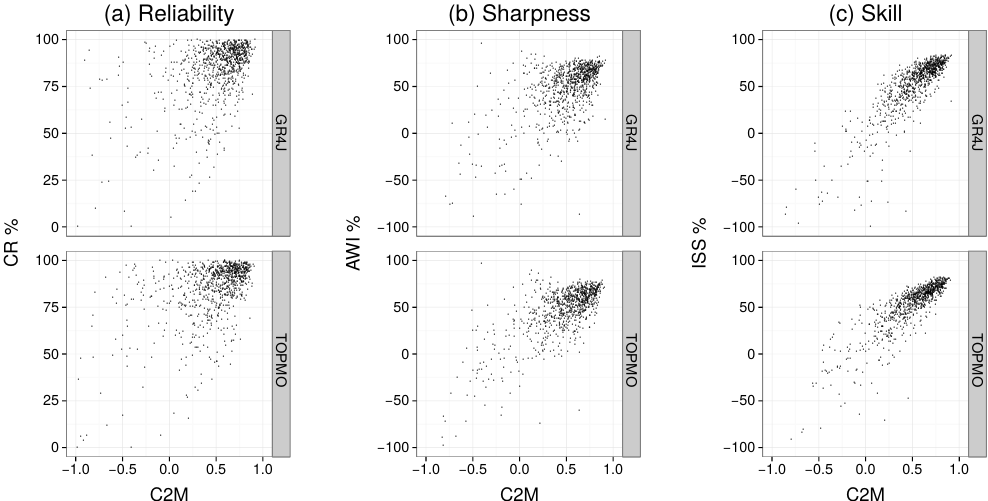
Figure 7. Impact of deterministic performance, as quantified by the bounded C2M quadratic criterion, on the three performance criteria for the 907 catchments. Note that for easier visualisation, the lower limits of the AWI (b) and ISS (c) values are set to − 100% but lower AWI values are obtained in seven cases for both models, and lower ISS values are obtained in 18 and 22 cases for GR4J and TOPMO,